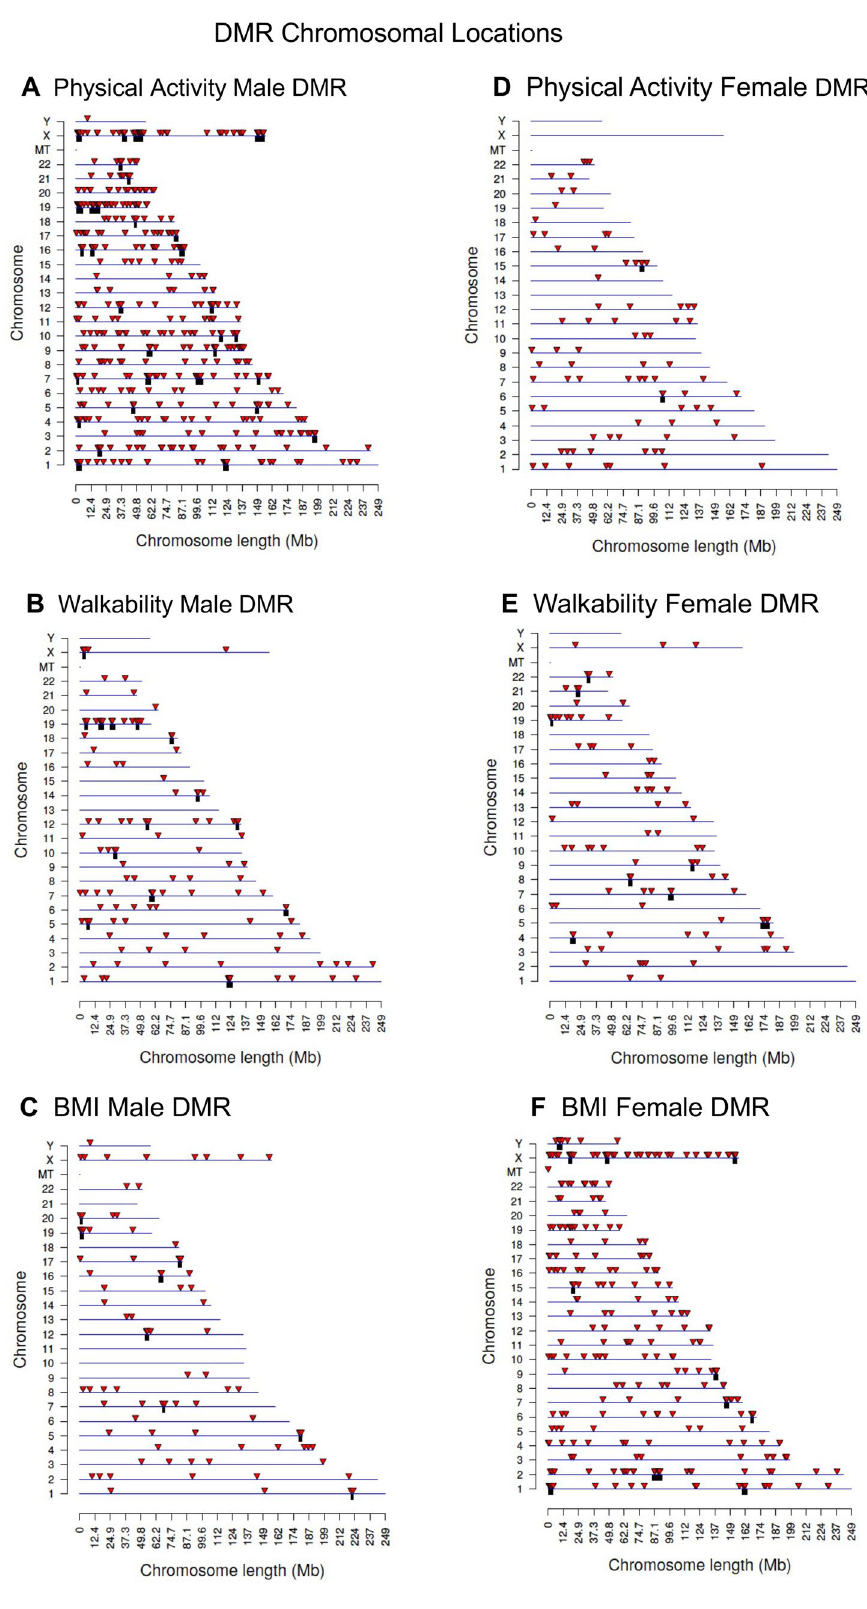
Figure 3. DMR chromosomal locations. The DMR locations on the individual chromosomes is represented with an arrowhead and a cluster of DMRs with a black box. All DMRs containing at least one significant window at a p value threshold of p < 1e−04 for DMR are shown. ( A ) Activity male DMR; ( B ) Walkability male DMR; ( C ) BMI male DMR; ( D ) Activity female DMR; ( E ) Walkability female DMR; and ( F ) BMI female DMR. The chromosome number versus size (megabase) is